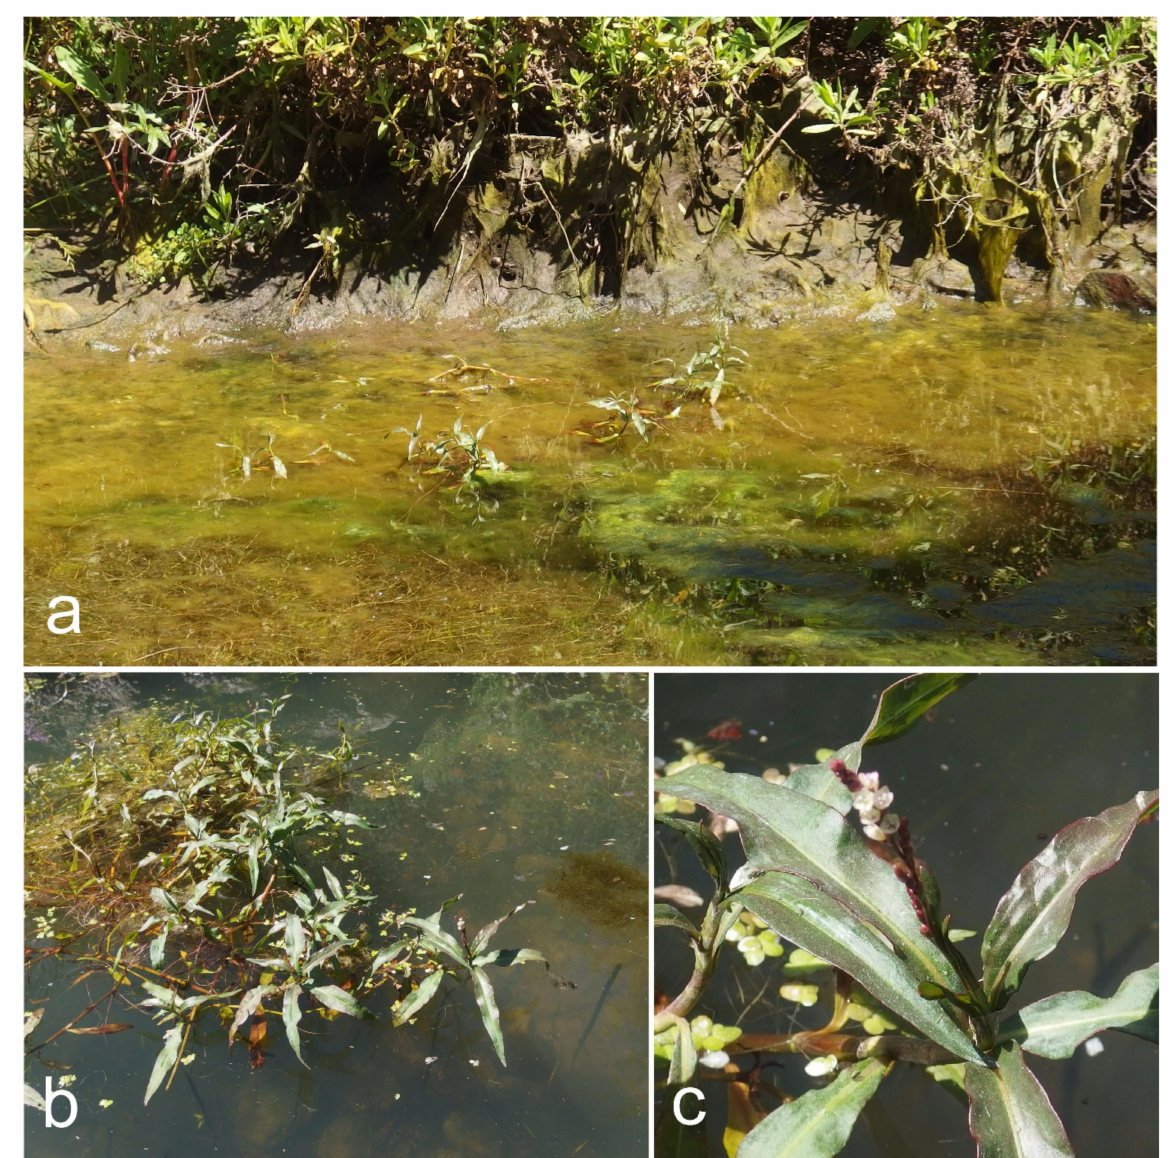
Figure 7. Persicaria hydropiperoides in Gran Canaria, Barranco de Lugarejos, April 2017: ( a – c ) in temporary pools the species behaves as a genuine aquatic species (Photographs: F.